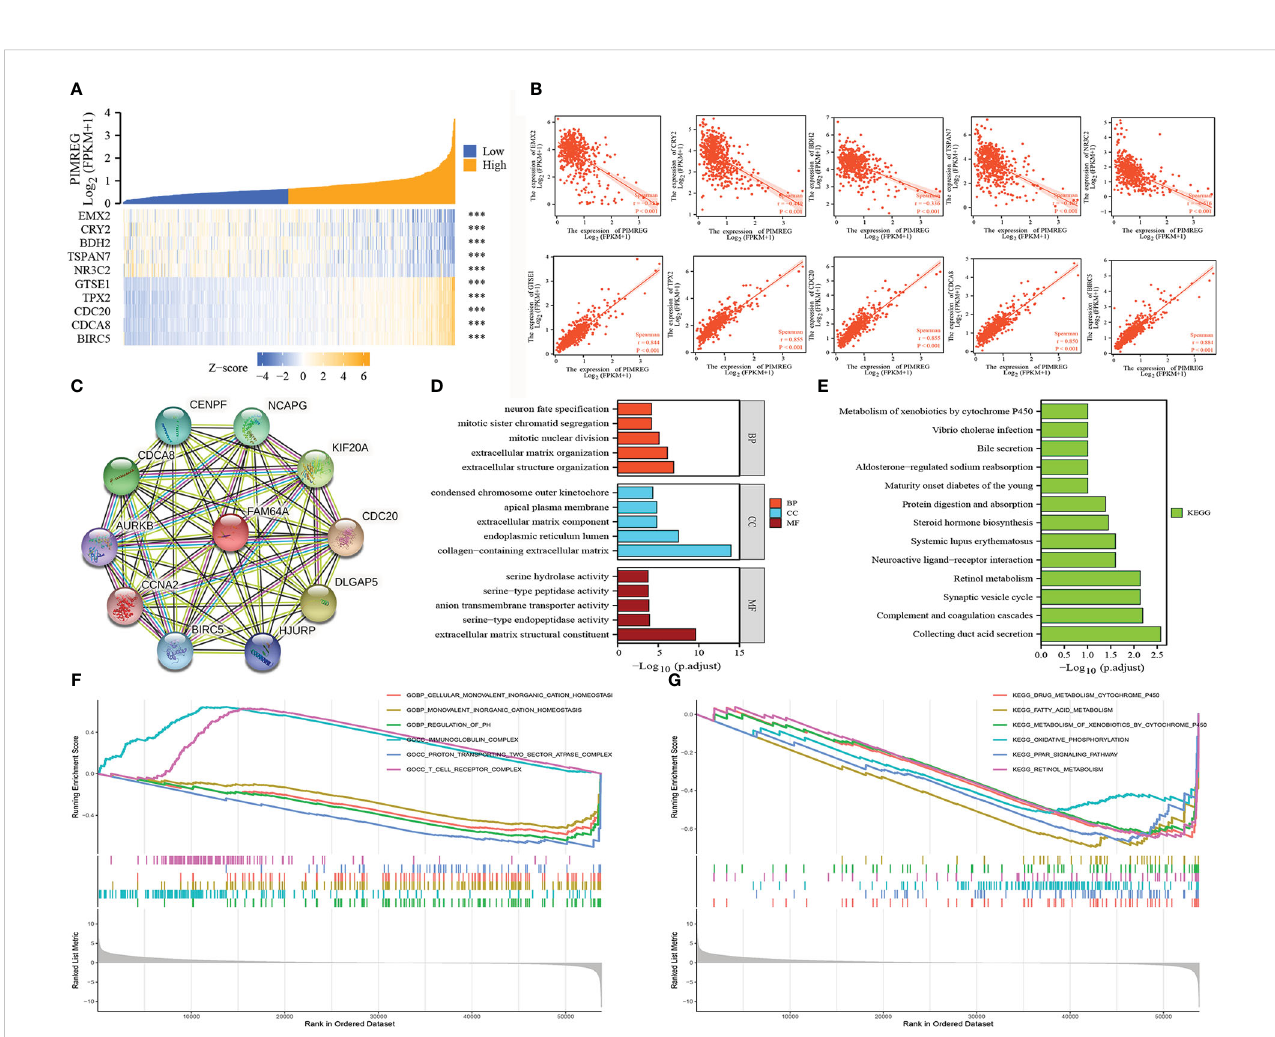
FIGURE 6 Related genes and functional annotation of PIMREG . (A, B) The fi rst fi ve genes that are positively or negatively correlated with the expression of PIMREG . (C) A network of PIMREG and its correlated genes. (D, E) GO and KEGG enrichment analyses about PIMREG . (F, G) GO term and KEGG pathway enrichment plots from GSEA analysis. GSEA, Gene Set Enrichment Analysis; GO, Gene Ontology; KEGG, Kyoto Encyclopedia of Genes and Genomes; ***P <